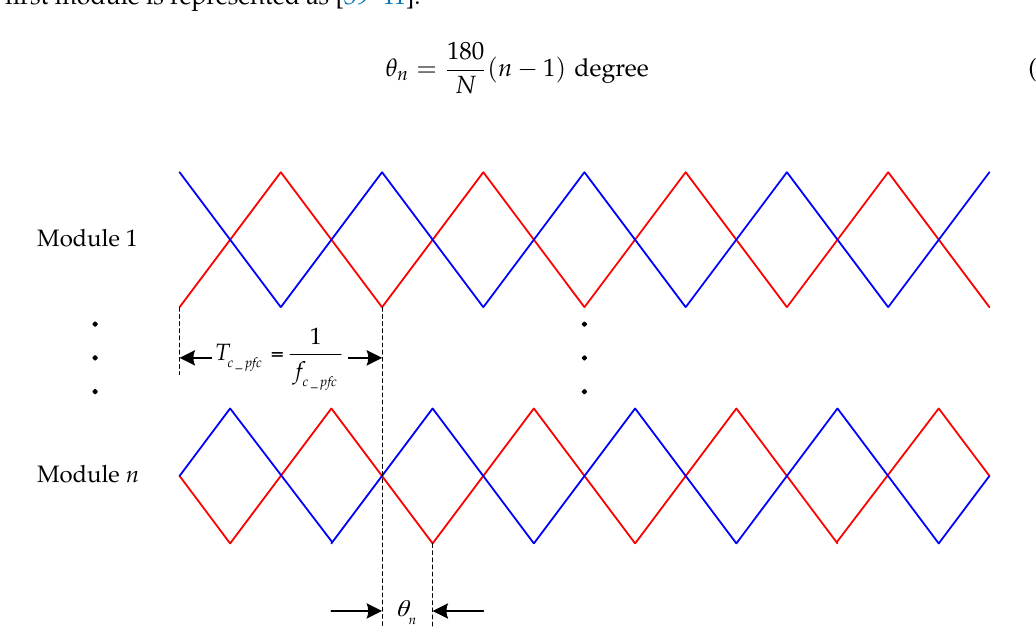
Figure 10. Carrier waveforms for individual modules.